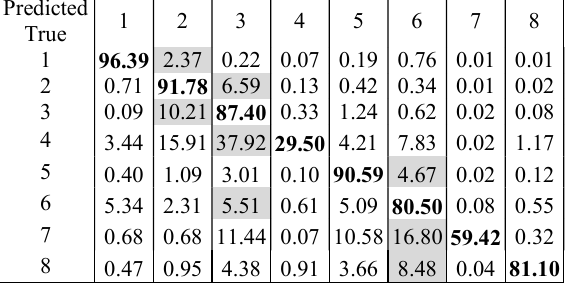
Table 7. Confusion matrix normalized by reference (in %) showing the classification result by feature set A